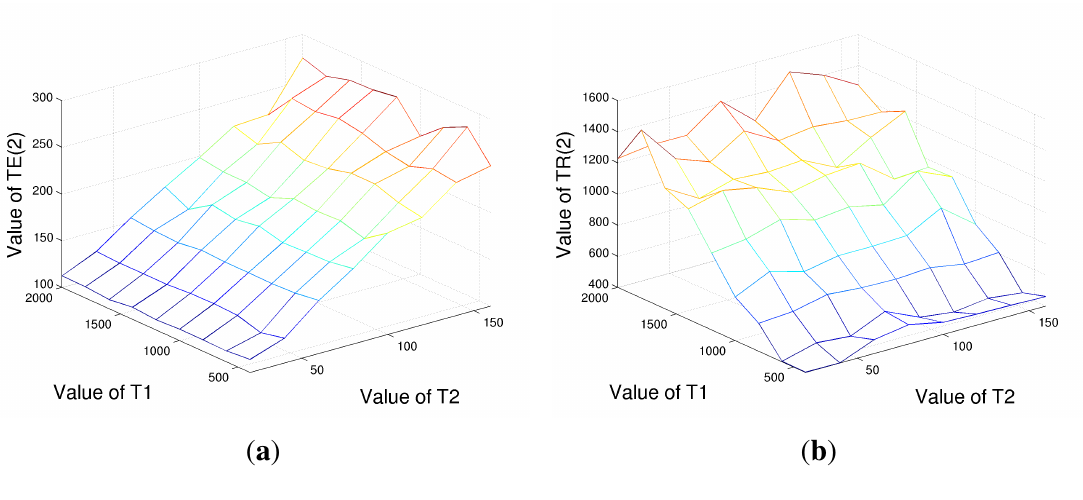
(2) ( a ) and T (2) ( b ) values considering nine acquisitions in the case E R and T relaxation times. It can be noticed that the T 1 2 . 2